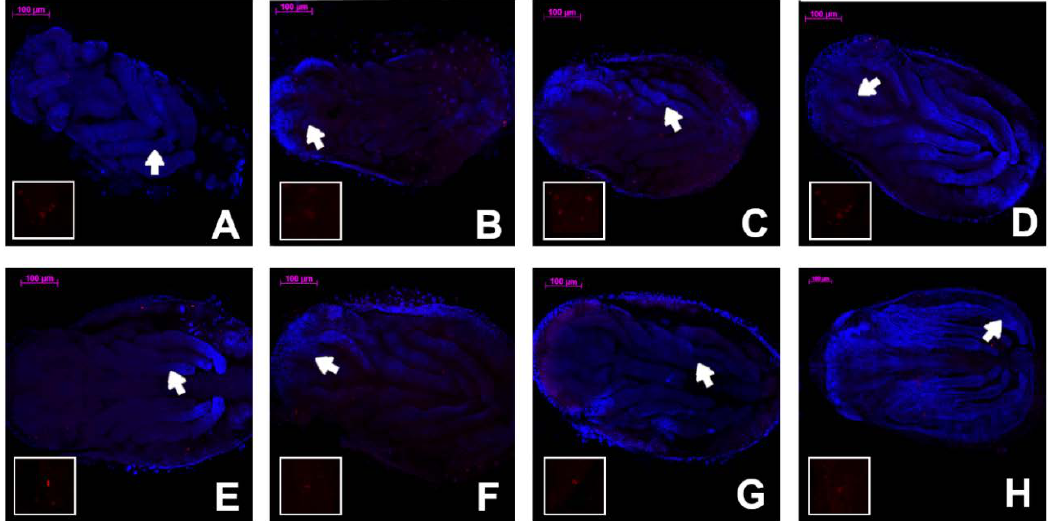
Figure 2. Development of Cinara juniperi embryo; in the gap there are red color cells in mitotic process from the place pointed by the arrow. The pictures show the stages of development on particular days of embryogenesis: ( A ) 16, ( B ) 21, ( C ) 35, ( D ) 42, ( E ) 49, ( F ) 56, ( G ) 63, ( H ) 70. All scale bars are 100 µm long. The embryos have a head directed to the left side.